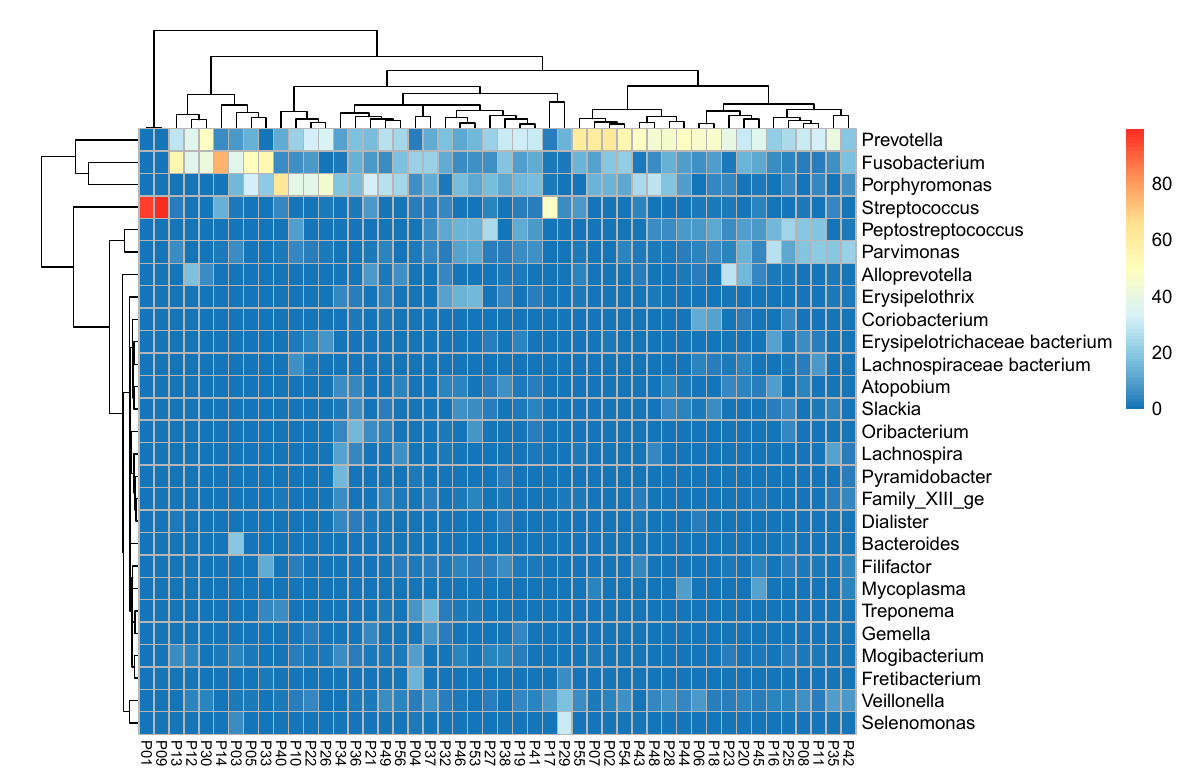
Figure 4. Heatmap of all ( n = 48) pus samples. Colors show the relative frequency of the reads of the most frequent bacterial genera (sum of rows >20%). Hierarchical clustering with a dendrogram (complete linkage with Euclidean distance).